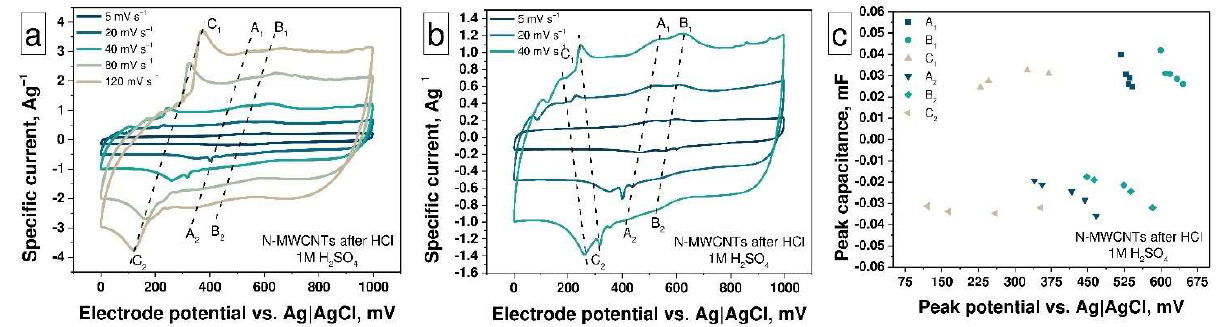
Figure 5. The CV curves at the scan rates in the range ( a ) from 5 to 120 mV · s − 1 and ( b ) from 5 to 40 mV · s − 1 ; ( c ) the peak capacitance vs. peak potentials plot for N-MWCNTs after HCl treatment.